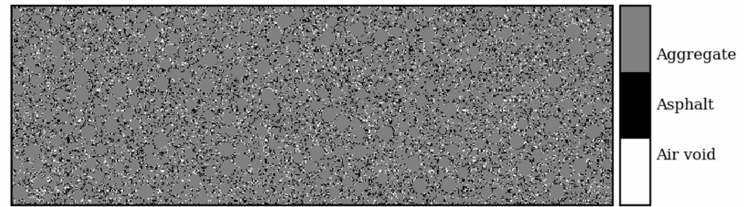
Figure 3. Example of a three-phase asphalt mixture numerical model.